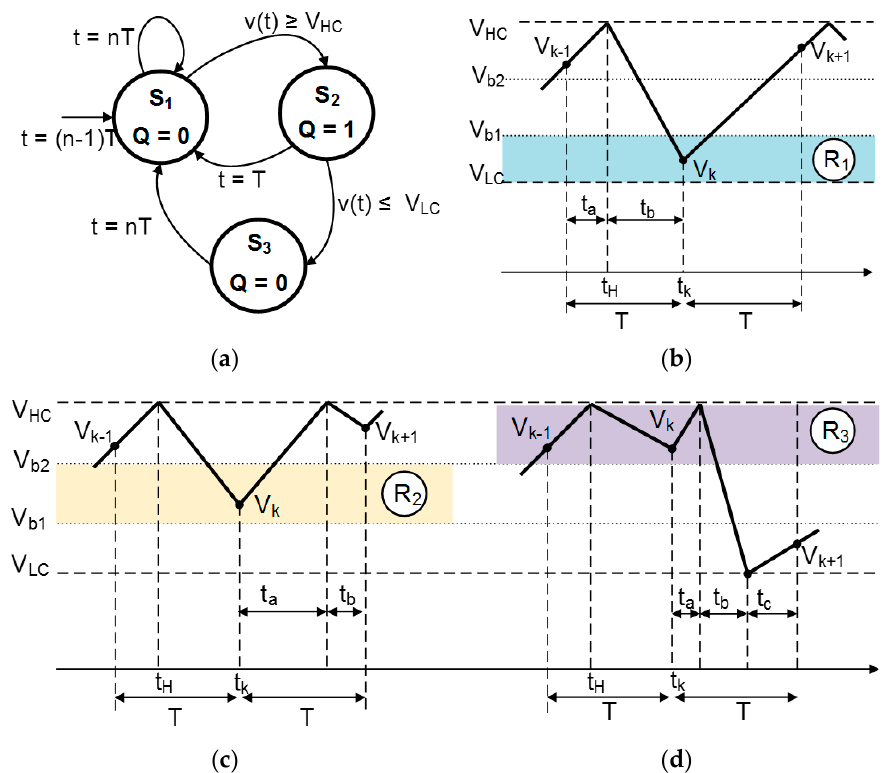
Figure 4. Operation of the N-shaped-based chaos generator: ( a ) Finite state machine. ( b – d ) Capacitor voltage waveform.